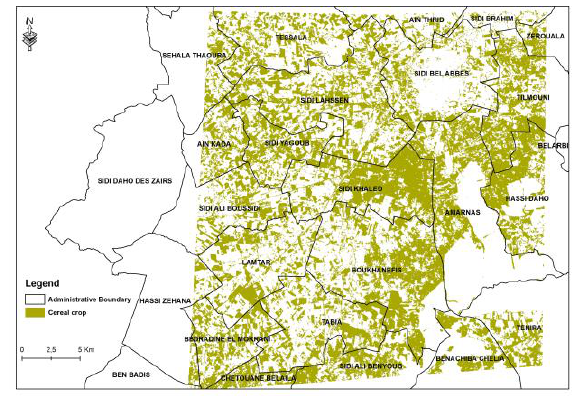
Figure 9 . Geographical extent of cereal crop.